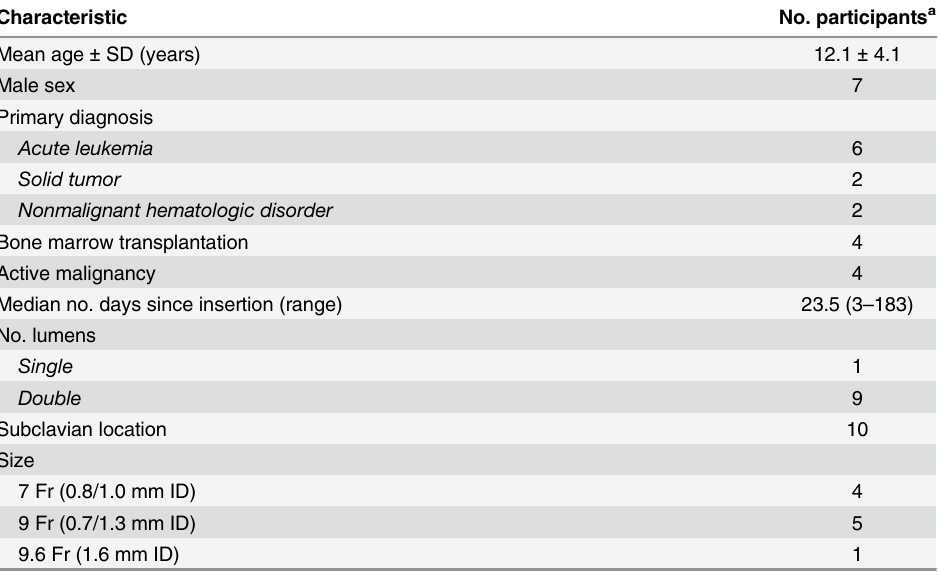
Table 1. Demographics and CVC specifications for 10 participants.